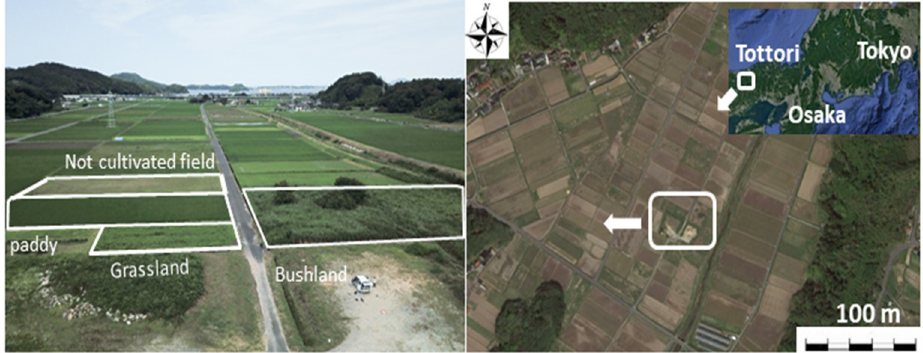
Figure 1. Study Site.